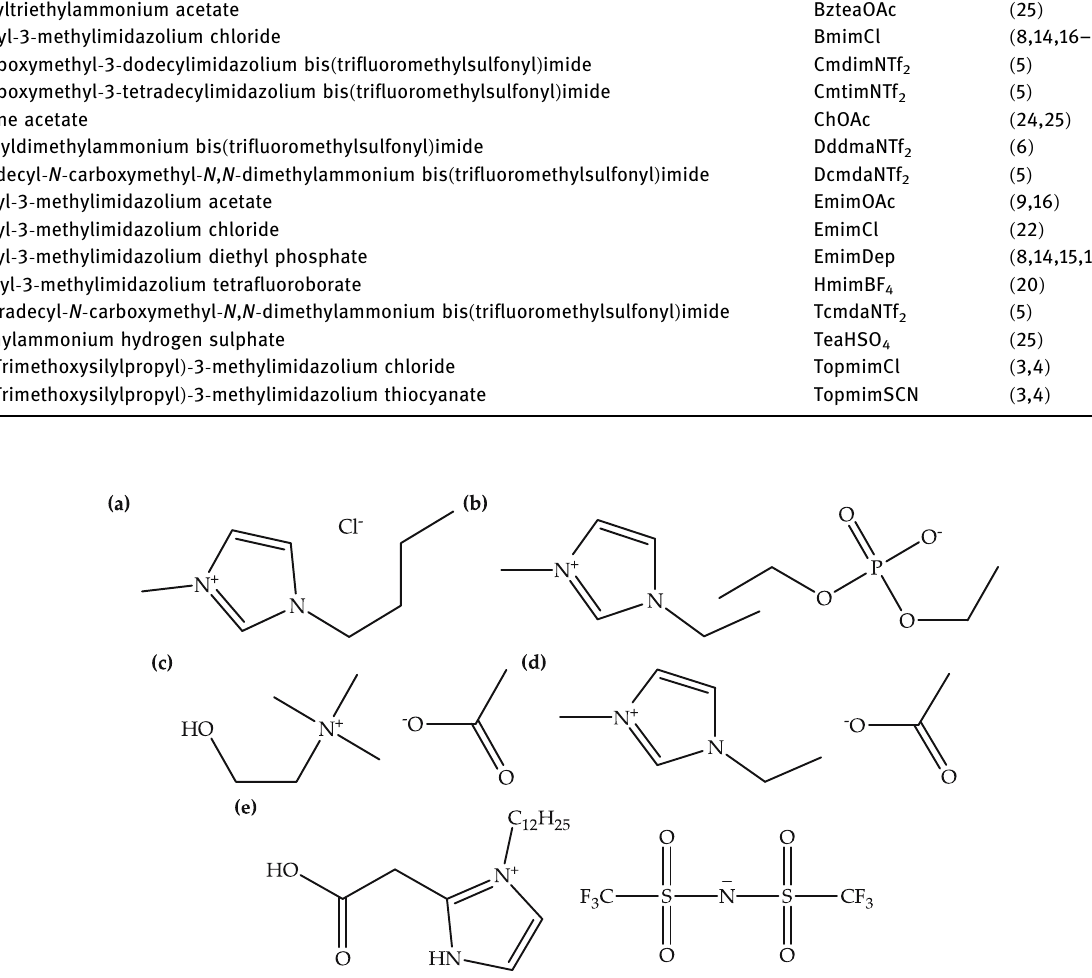
Table 2: Examples of ionic liquids used for the pretreatment of natural fi llers Ionic liquid